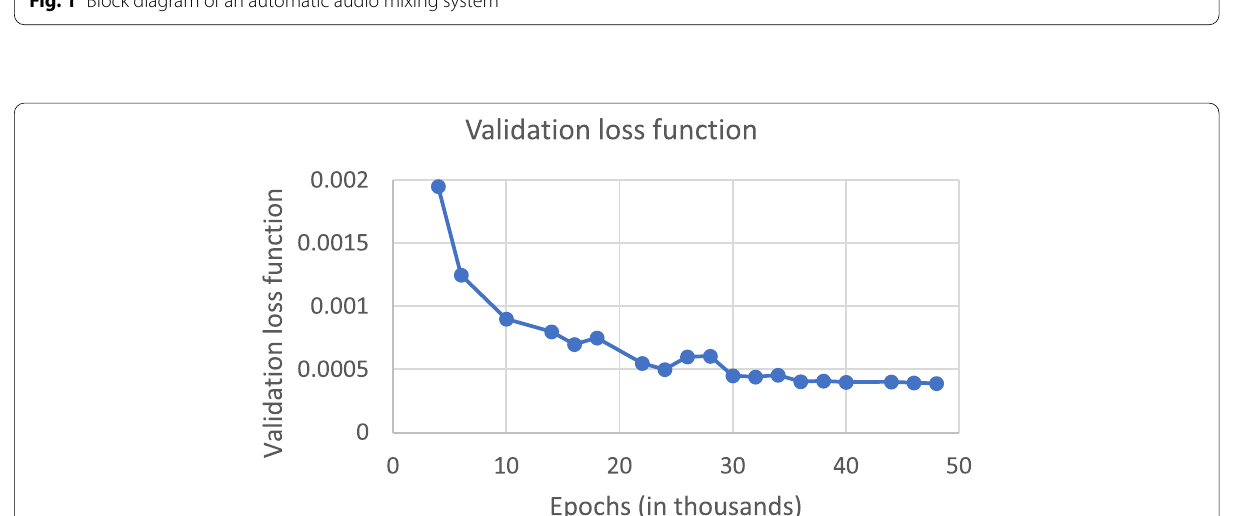
Fig. 2 The validation loss function of stem-to-mix model